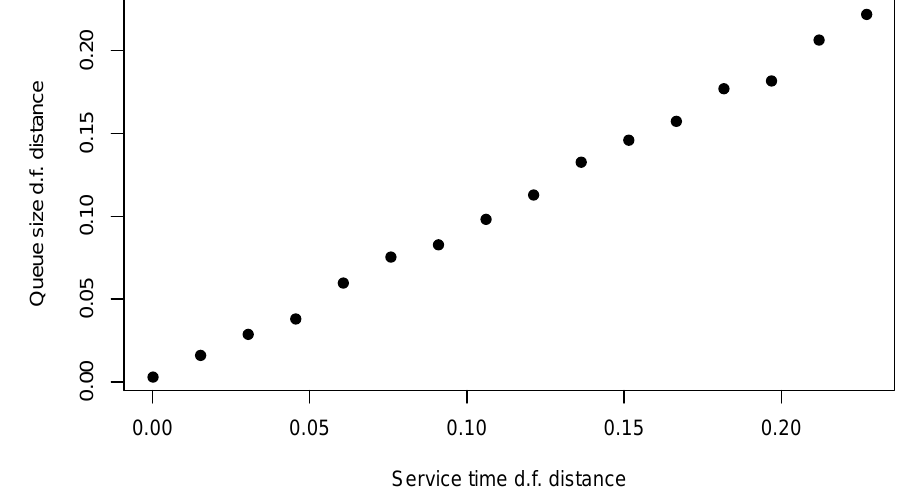
Figure 4. Distance between the empirical queue size d.f. in a basic M / G / c system with c = 4, ρ = 0.5, F 1 being Pareto ( 2.1,1 ) service time d.f. and λ = 2.2, and system with a mixture, F M of Pareto ( 2.1,1 ) and Pareto ( 4.9,1 ) service time d.f. vs. the distance between F 1 and F M , for varying p = 1,0.95, . . .